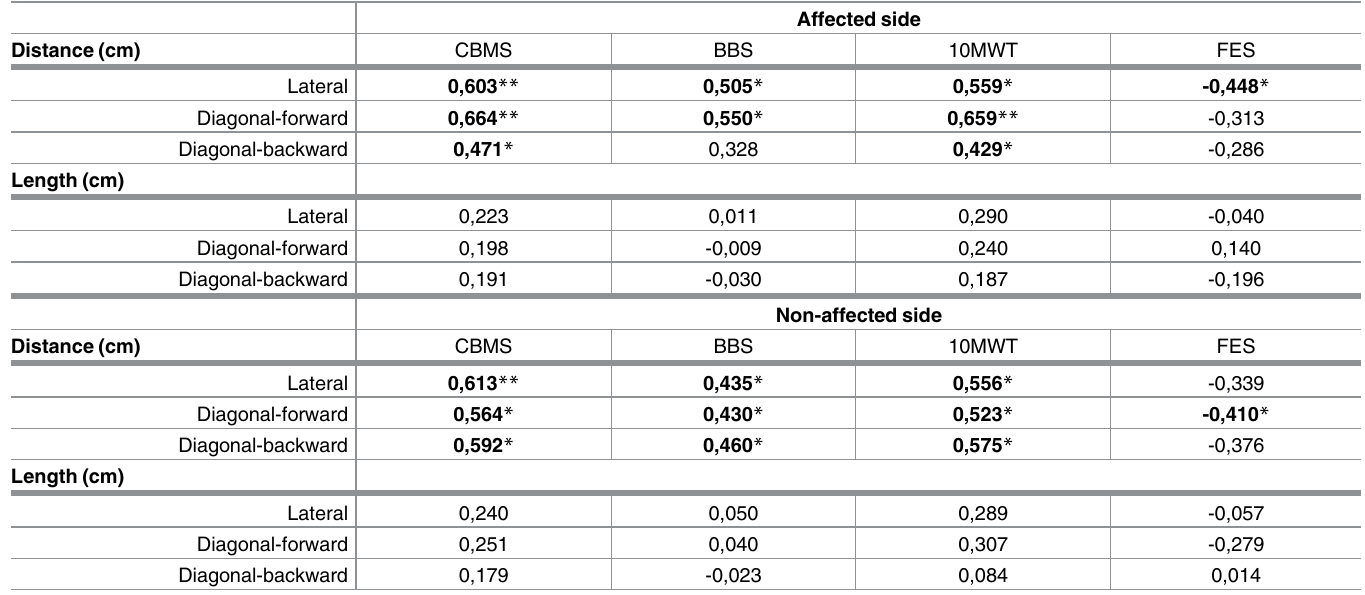
Table 4. Spearman’srho correlation coefficients of the force platform parameters and clinical outcome measures.